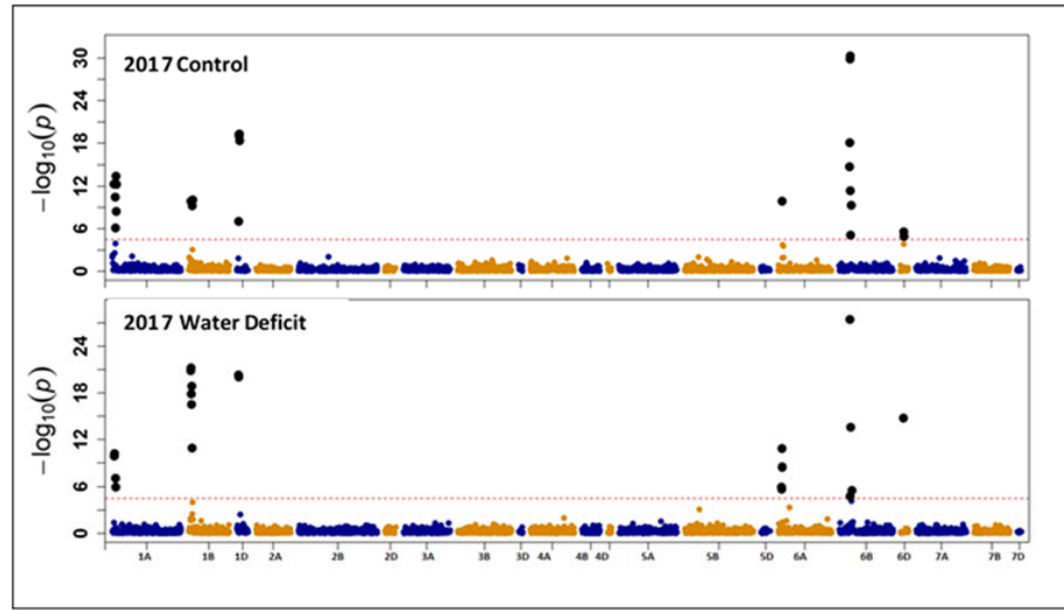
Figure 3. Manhattan plot for grain protein content (GPC) obtained from genome ‐ wide association mapping in the 2016 growing season.